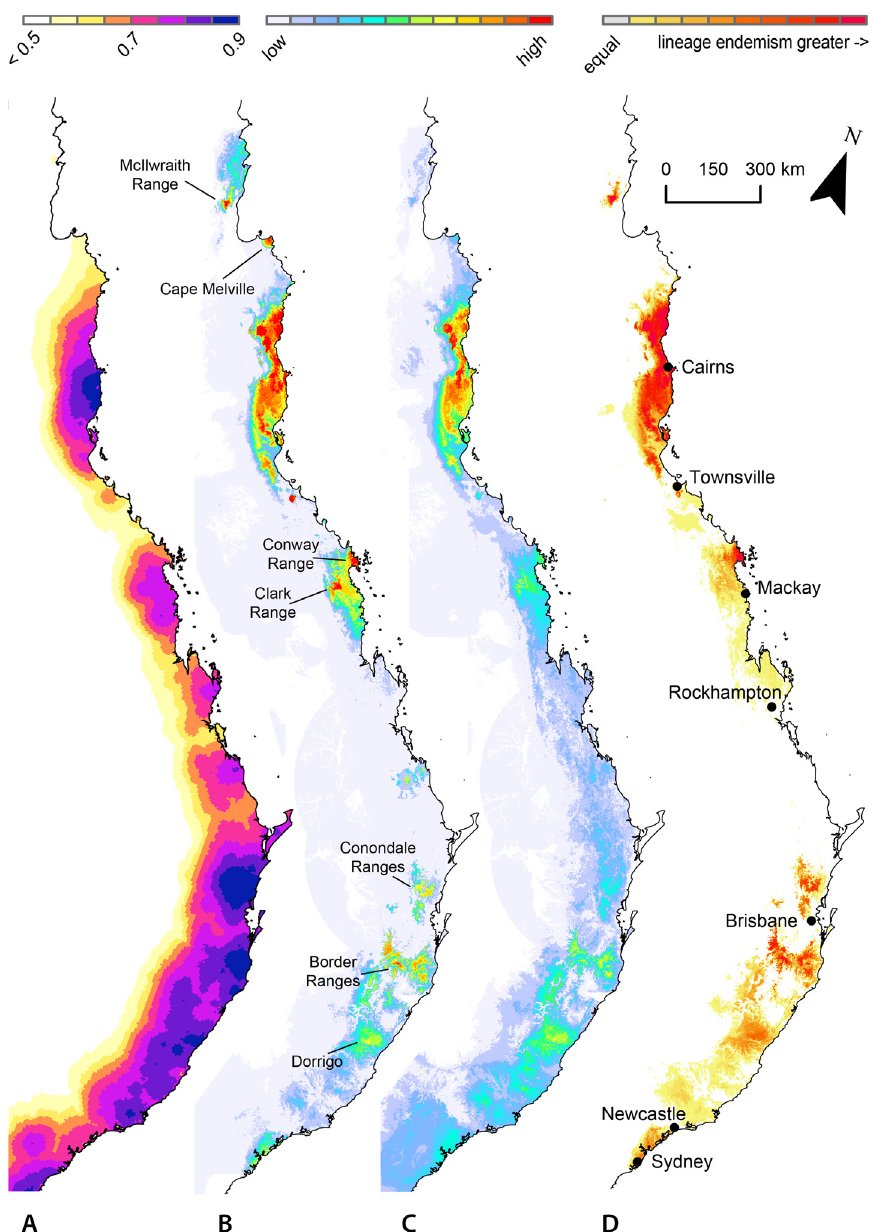
Fig 4. A) Paleo habitat stability of rainforest since 120 ka using the dynamic stability model allowing dispersal at 10 m yr -1 . B) Model-weighted lineage endemism peaks in the AWT just north of Cairns, and shows distinct highlights in a small subset of each rainforest region, such as Cape Melville in CYP, Conway Range and Eungella in MEQ, and the Border Ranges just south of Brisbane. C) Model-weighted species richness. D) Lineage endemism minus species endemism. Red areas have far greater lineage than species endemism, identifying concentrations of spatially restricted diversity, which would be missed in a species- level analysis. Colors by quantile classes for each map. Note that for compact map presentation, north is offset by 20° as